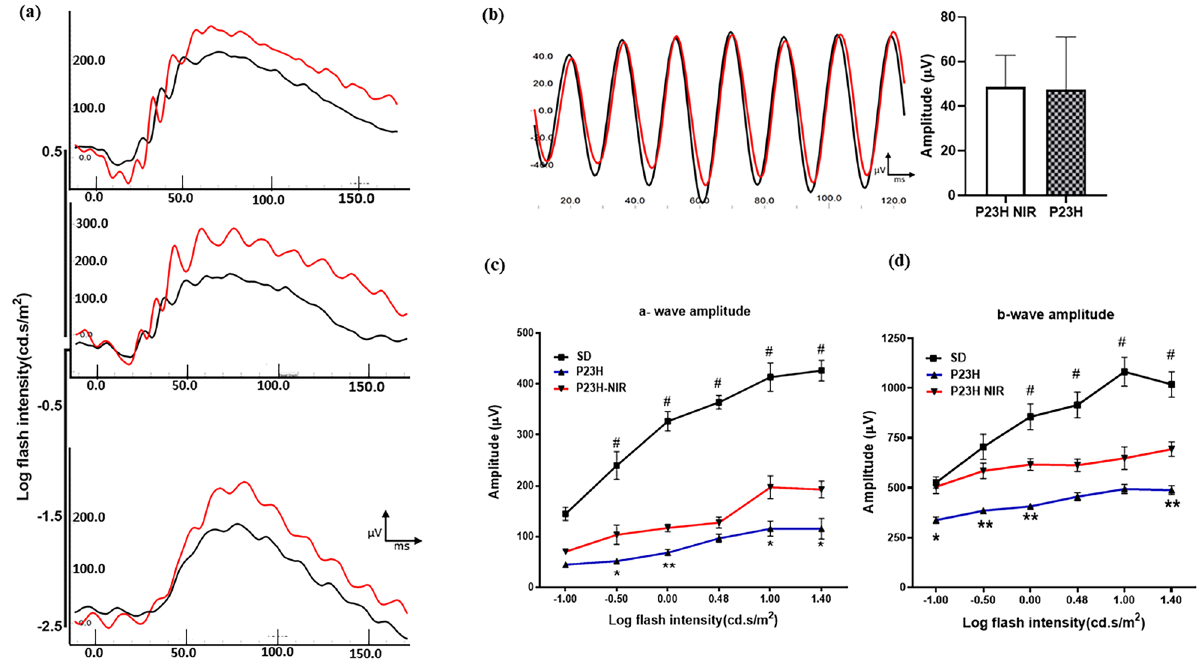
Figure 3. Photobiomodulation protects retinal function, assessed by ERG analysis. ( a ) Shows representative ERG waveforms measured in dark-adapted sham-treated (black) and 830 nm PBM-treated (red) P23H rats by ISCEV protocol 34 at the lowest (10mcd.s/m 2 ) and the highest flash intensities (3000 and 10,000 mcd.s/ m 2 ). 830 nm PBM treatment improved the b-wave response at low stimulus intensities and the a and b wave responses at higher stimulus intensities. ( b ) Illustrates standard flicker response in the ISCEV protocol (3 cd.s/m 2 @ 30 Hz) representing cone function in sham-treated and PBM-treated rats. Representative flicker responses are shown in P23H (black) and PBM-treated P23H (red) rats. There was no statistical significance observed in the flicker response between the sham-treated and 830 nm PBM-treated rats. ( c ) and ( d ) show the mean a-wave and mean b-wave ERG amplitudes (respectively) measured by scotopic intensity series protocol comparing P23H transgenic retina (filled square) and 830 nm treated P23H retina (filled triangle). 830 nm PBM treatment produced a significant increase in both a-wave (F (1,14) = 16.32, p < .001; n = 8) and b-wave amplitudes (F (1,22) = 23.57, p < .001; n = 12) at all flash intensities compared to the P23H group. Error bars: